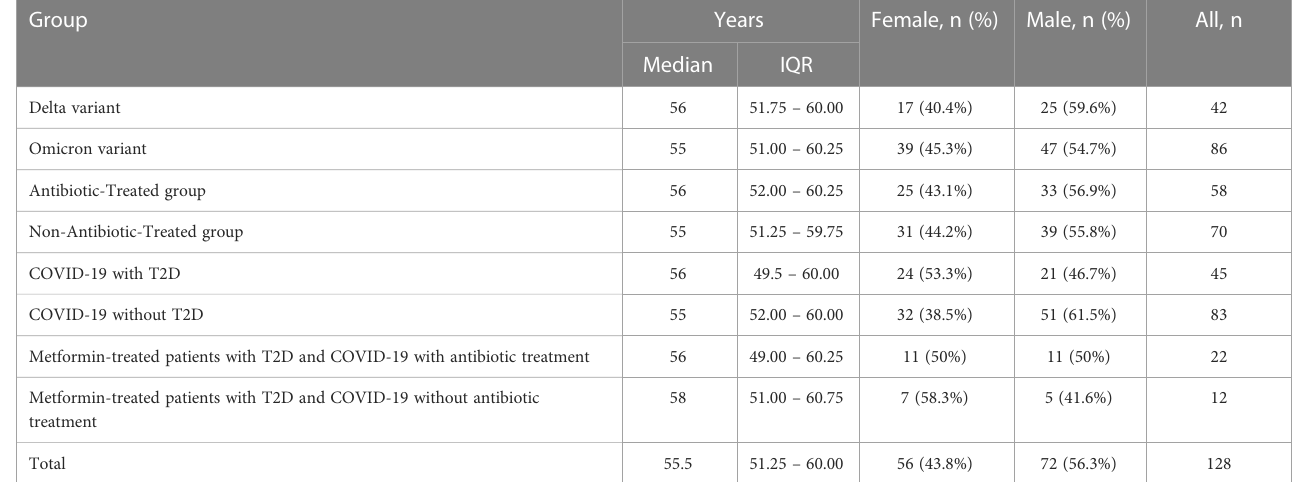
TABLE 1 Basic characteristics of the study